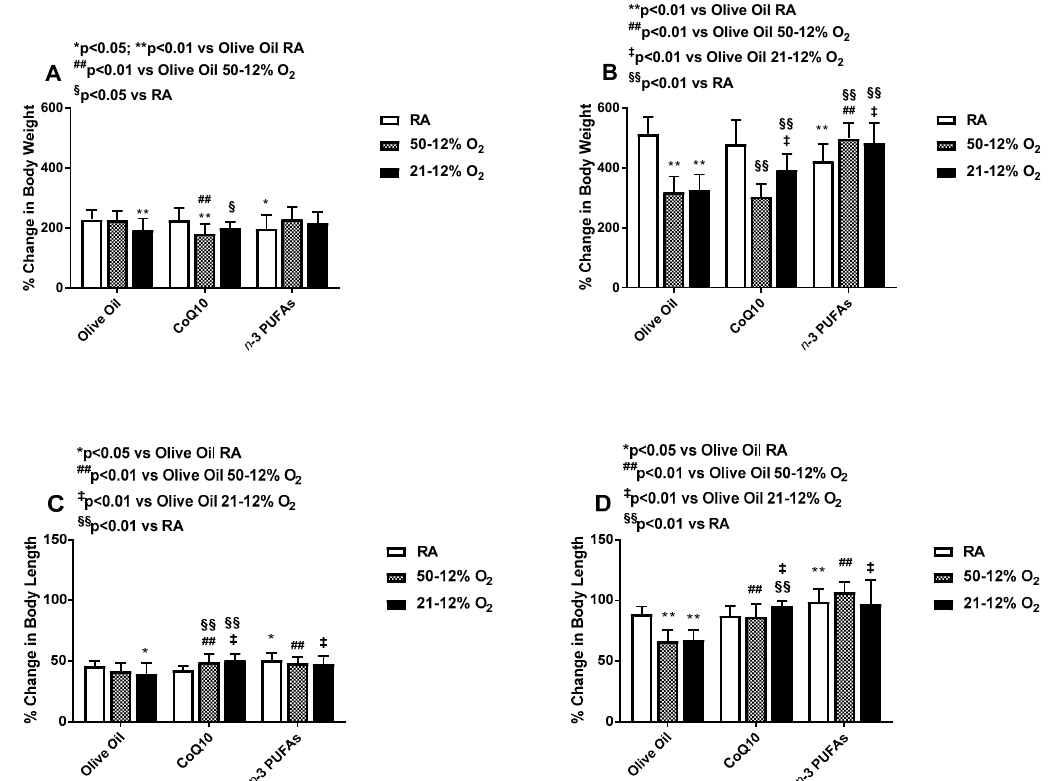
Figure 2. Effects of neonatal intermittent hypoxia (IH) with Co-Q10 or n -3 polyunsaturated fatty acids (PUFA) supplementation on percentage change in body weight panels ( A , B ), and linear growth panels ( C , D ). Panels ( A , C ) represent treatment during IH exposure and supplementation for 14 days, and panels ( B , D ) represent recovery from IH (IHR) in room air (RA) with no treatment. The white bar represents normoxia control animals exposed to RA only. These animals were raised in atmospheric oxygen from birth to P14 or P21. The hashed bar represents animals exposed to 50–12% O 2 , and the solid black bar represents animals exposed to 21–12% O 2 . Data are expressed as mean ± SD ( n = 8 samples/group).